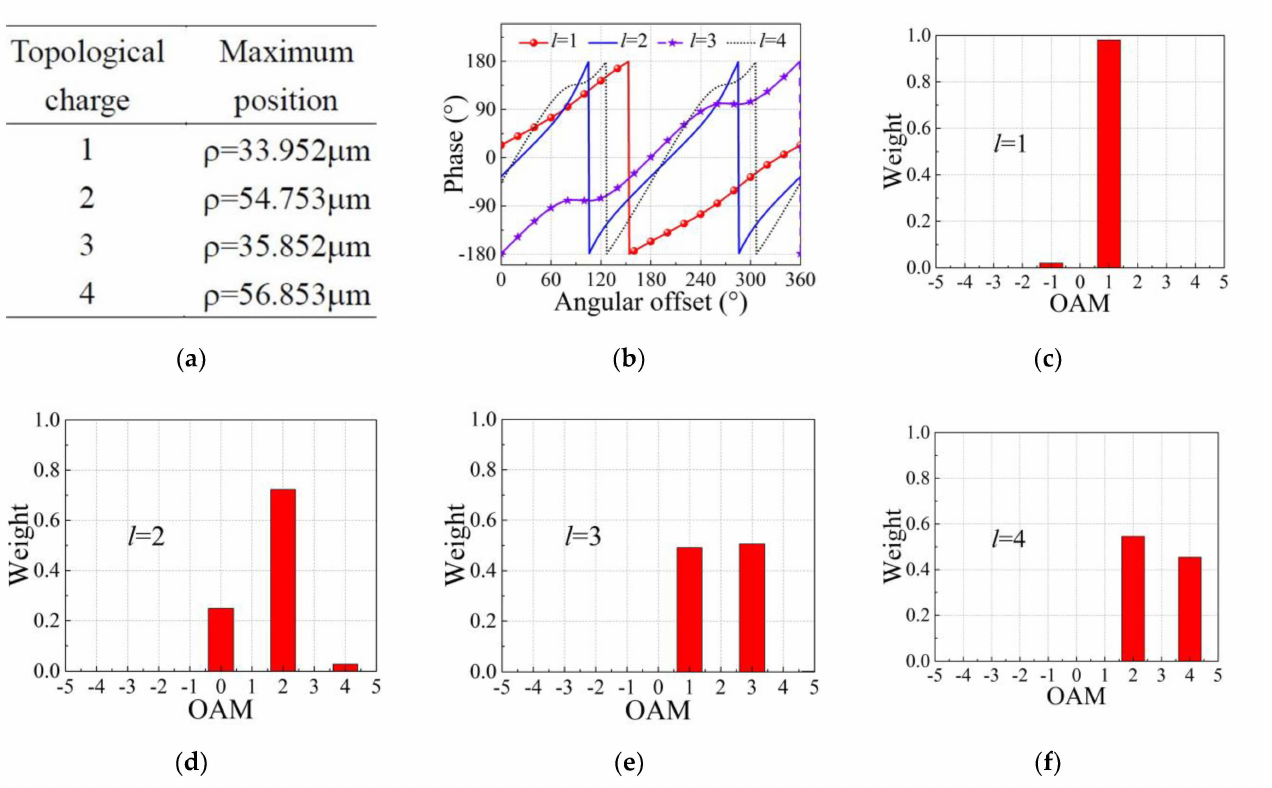
Figure 15. The same as in Figure 12, with the simulated scattered field. The scatterer is changed into a charged particle where other parameters remain unchanged. The surface electrostatic potential of the charged particle is ϕ = 50 V and the surface temperature is T = 30